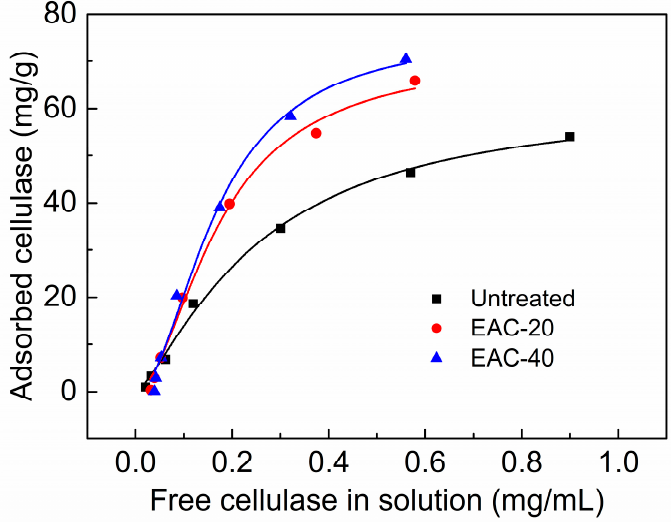
Figure 1. Enzymatic hydrolysis profile of poplar wood untreated and pretreated with [Emim]Ac at 90 °C. EAC-20: [Emim]Ac pretreated for 20 min. EAC-40: [Emim]Ac pretreated for 40 min. Error bars indicate standard deviation.